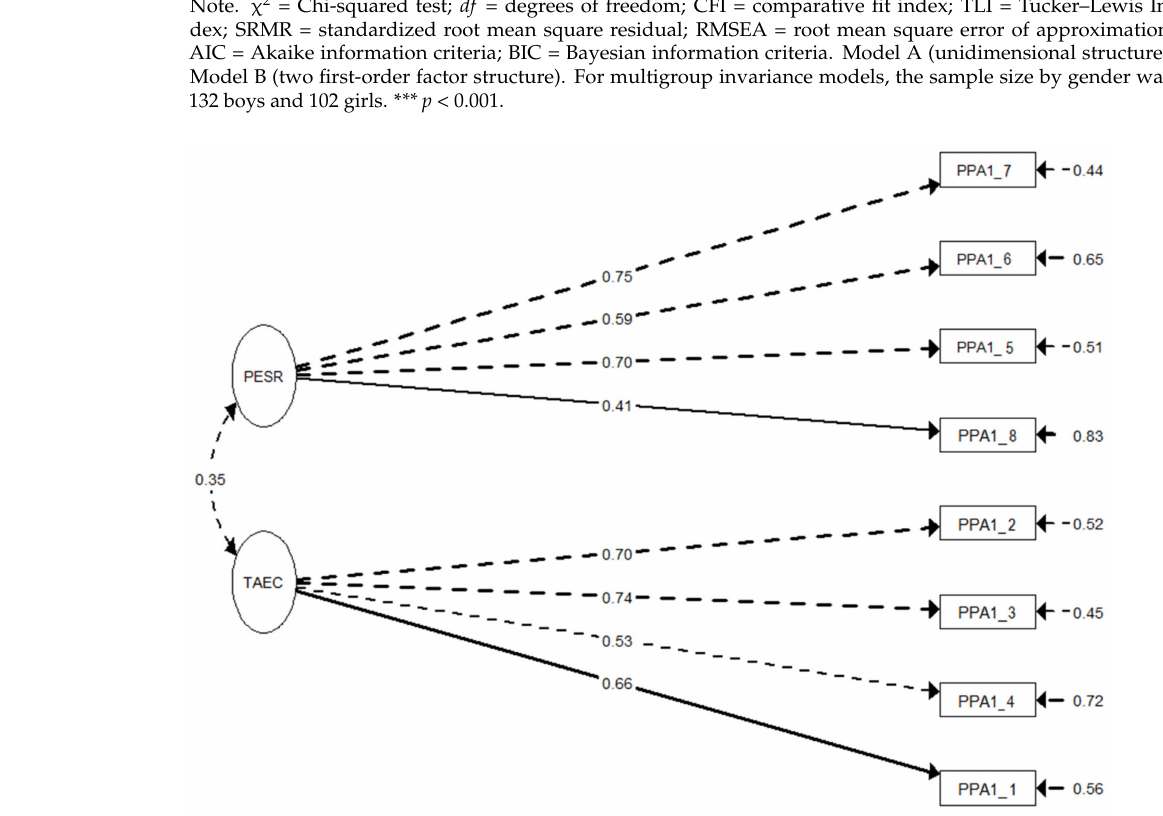
Figure 2. First-order factor structure, standardized factor loadings, and variances of the Children’s Intake Self-Regulation Feeding Practices Scale. Note. Latent factor labels reflect the following dimen- sions: PESR (Prompting of eating self-regulation) and TAEC (Teaching about eating consequences). Solid lines illustrate the item whose factor loading was constrained to